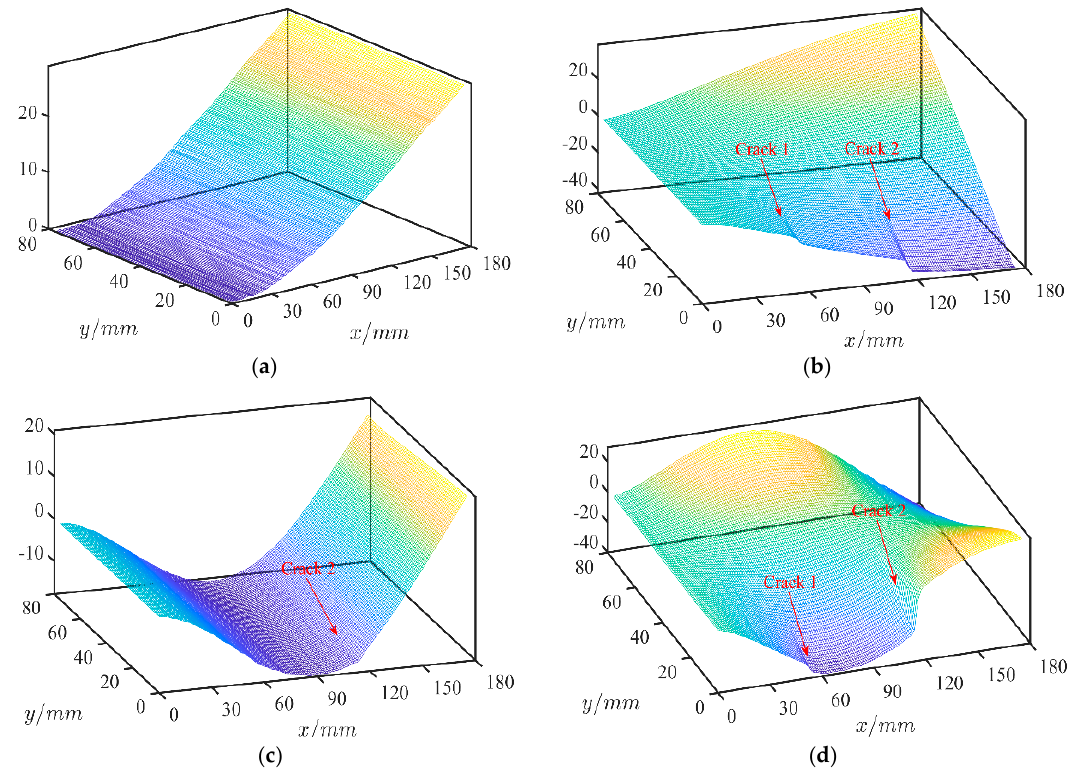
Figure 10. The first four measured mode shapes of the multi cracks plate using uniform-rate scanning CSLDV. ( a ) The first bending mode. ( b ) The first torsion mode. ( c ) The second bending mode. ( d ) The second torsion mode.